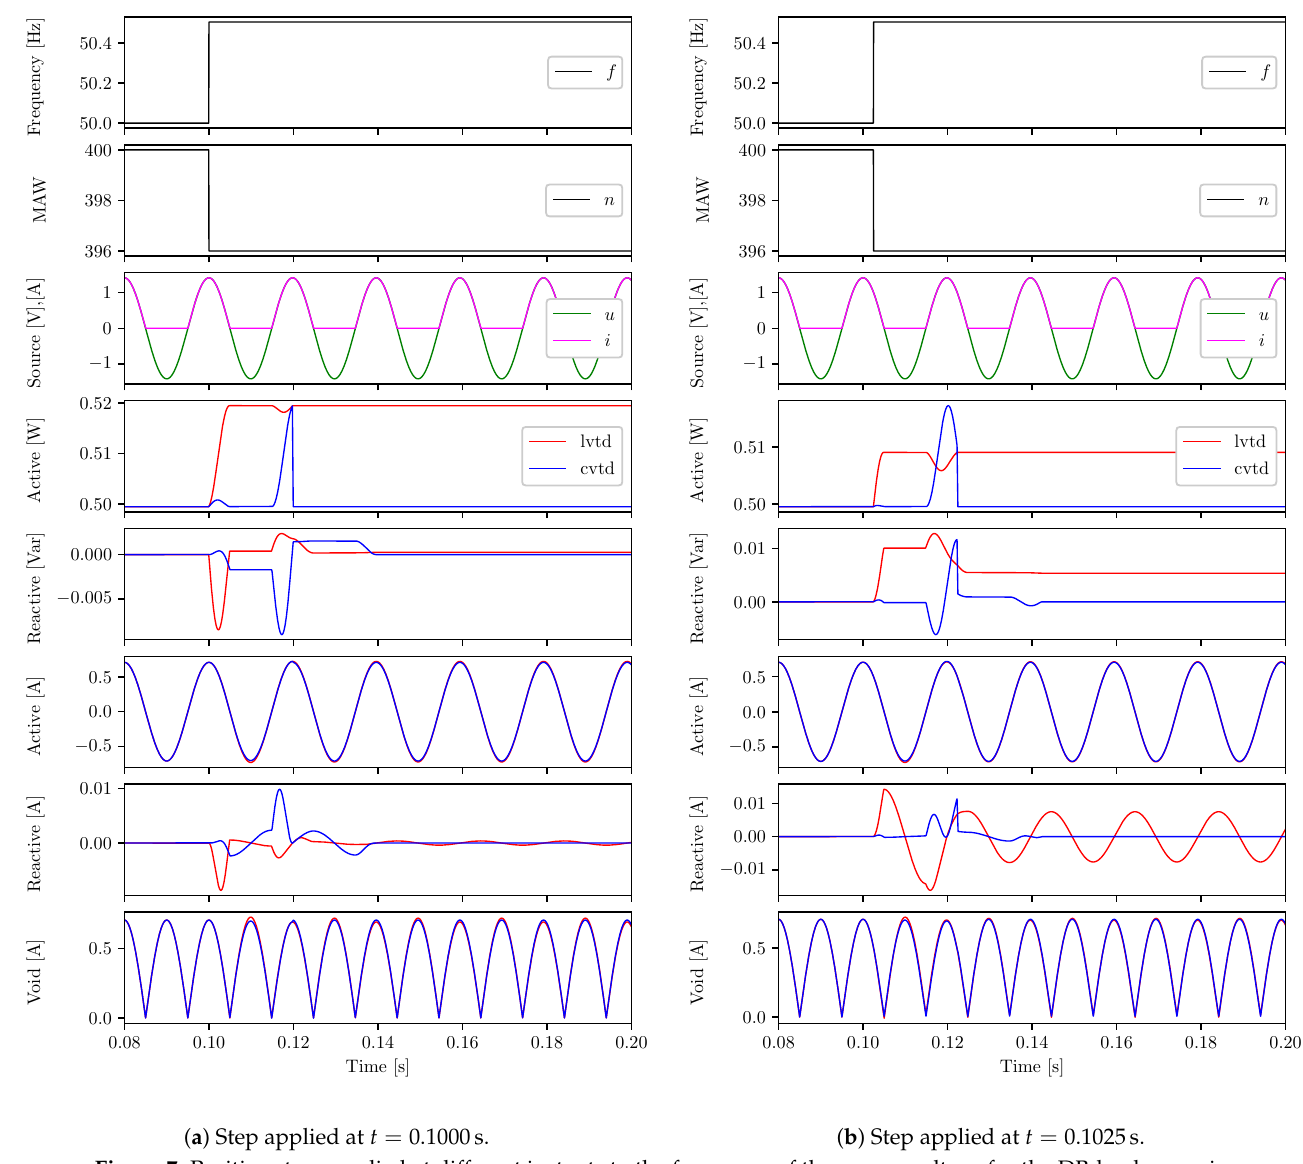
( a ) Step applied at t = 0.1000s. ( b ) Step applied at t = 0.1025s. Figure 7. Positive steps applied at different instants to the frequency of the source voltage for the DB-load scenario. Reactive power : should be zero irrespective of the frequency step. The transient after the step lasts for two periods due to the cascaded AMAs. The measurements with CVTDs settle at the expected value after the transients. The steady-state errors introduced by LVTDs depend on which slots of the circular buffers are skipped. The error is barely noticeable in Figure 7a; however it is close to 0.5% of a full scale of 1 Var in Figure 7b. Active current : neither the transients nor the steady-state measurement differences are noticeable in the curves at the scale shown. Reactive current : is expected to be zero irrespective of the frequency variation. The er- ror in the reactive current with LVTDs in Figure 7a is barely noticeable. This is a conse- quence of the small error in the reactive power for the step at instant t = 0.1 s. On the other hand, the reactive current measured with LVTDs features a clear 50 Hz oscillation in Figure 7b. The measurements with CVTDs behave as expected. Void current : the differences between the measurements from the CPT transducers with LVTDs and CVTDs are barely noticeable during the transient between t = 0.1 s and t = 0.14